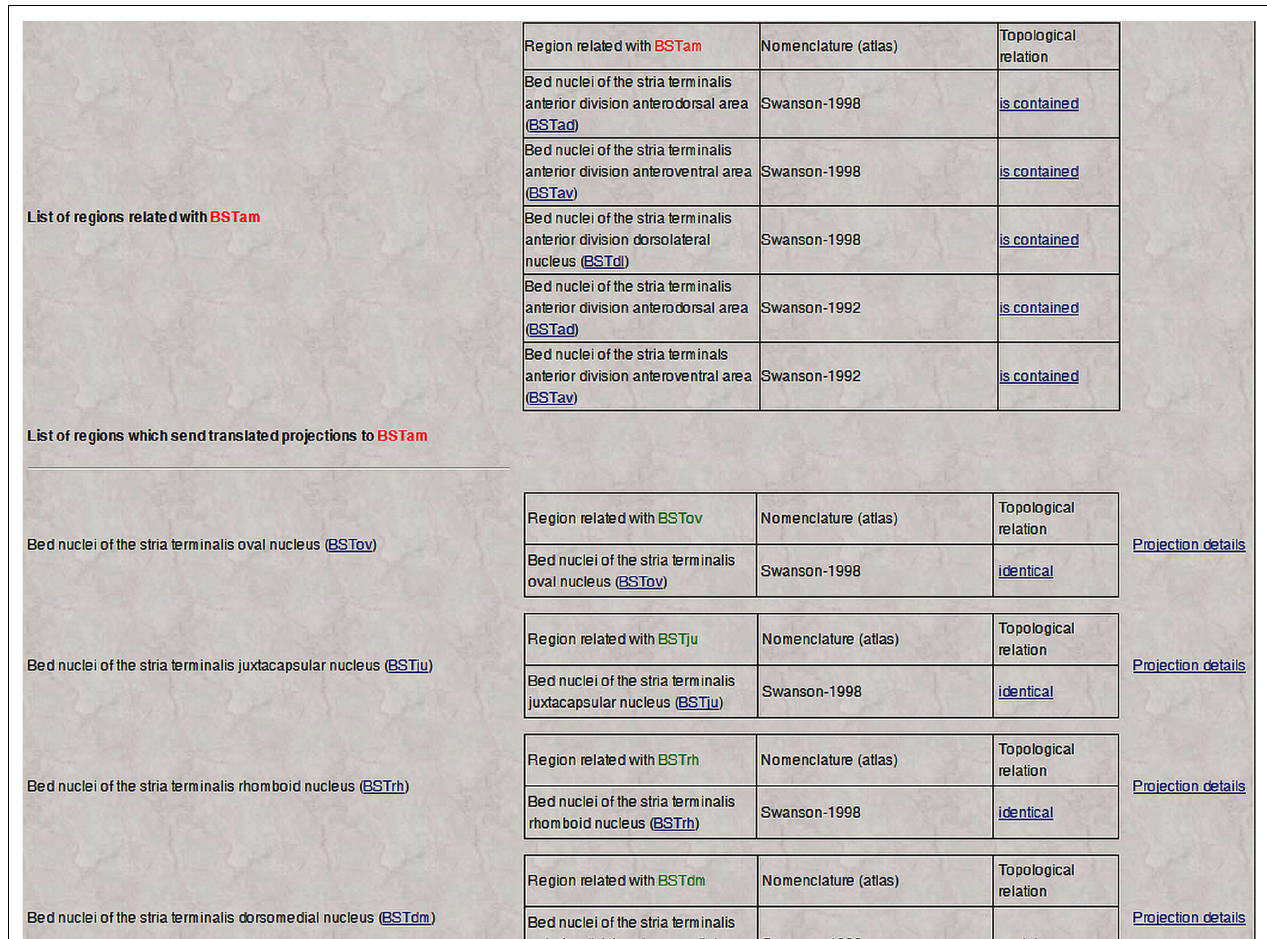
FIGURE 5 | An example of neuroanatomical ProjectionsTranslations inference engine output. The screenshot lists the inferred projections of BSTrh defi ned in rat Swanson (2004) nomenclature. The topologically-based ProjectionsTranslations inference engine fi rst lists all nervous system regions related with the region of interest and defi ned in different nomenclatures. The